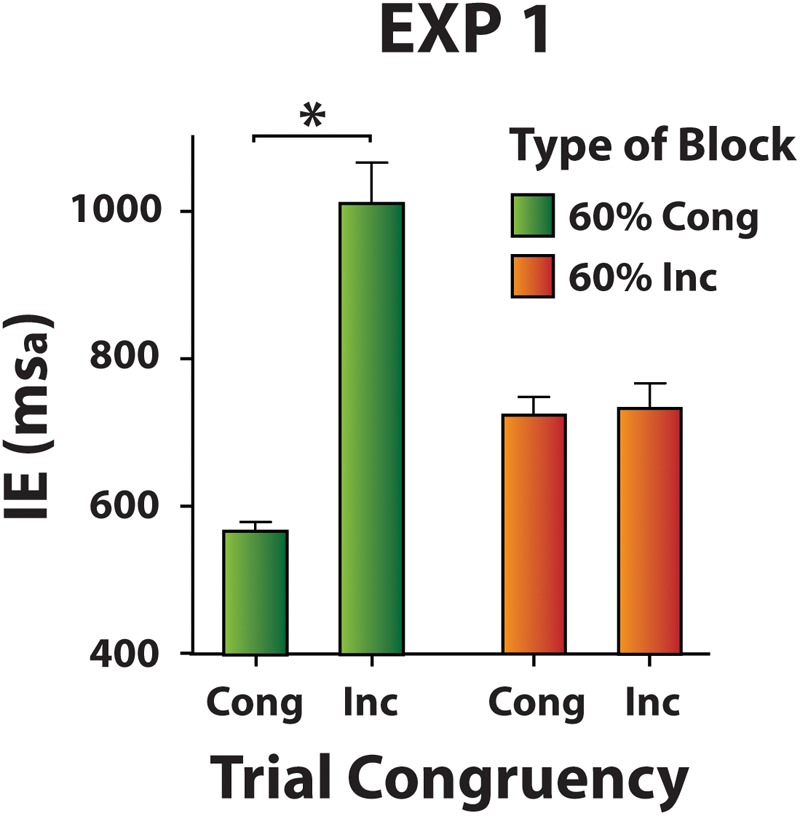
Distractor-present trials in Mixed blocks (Experiment 1). Mean IE values show a positive congruency effect in the 60% Cong blocks and no congruency effect in the 60% Inc blocks. Asterisks mark significantly different mean/s.